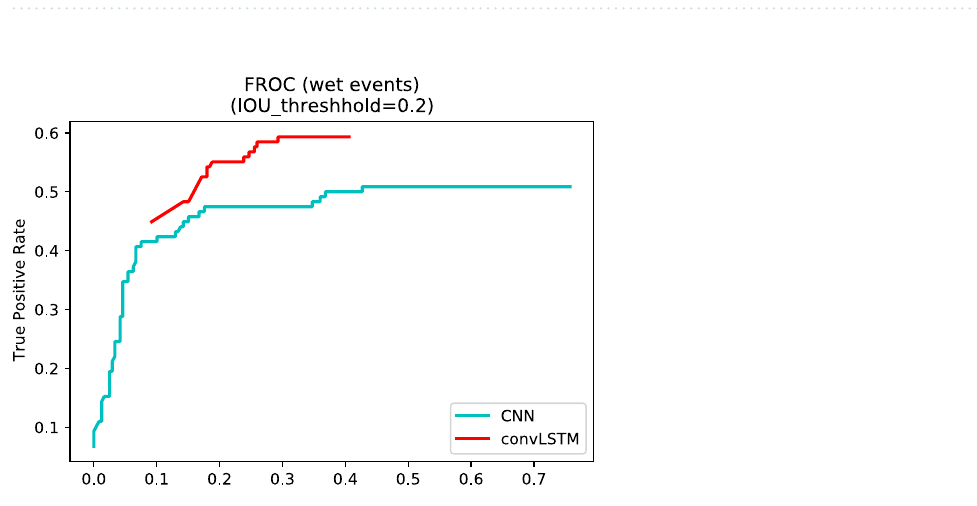
Table 6. Comparison of the best semi-supervised models for the plain CNN and the temporal convLSTM model.